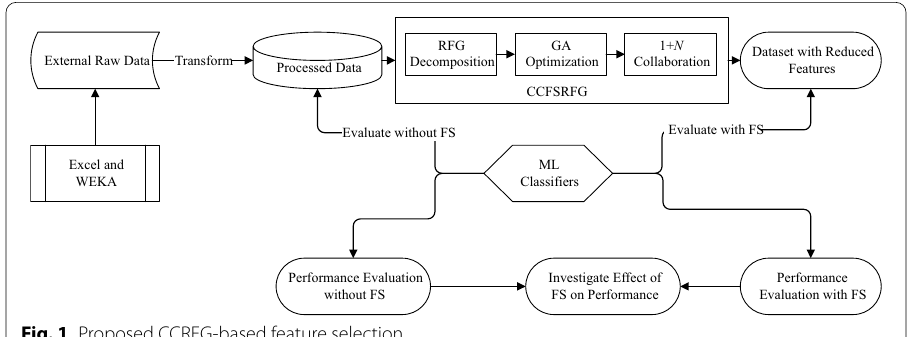
Fig. 1 Proposed CCRFG‑based feature